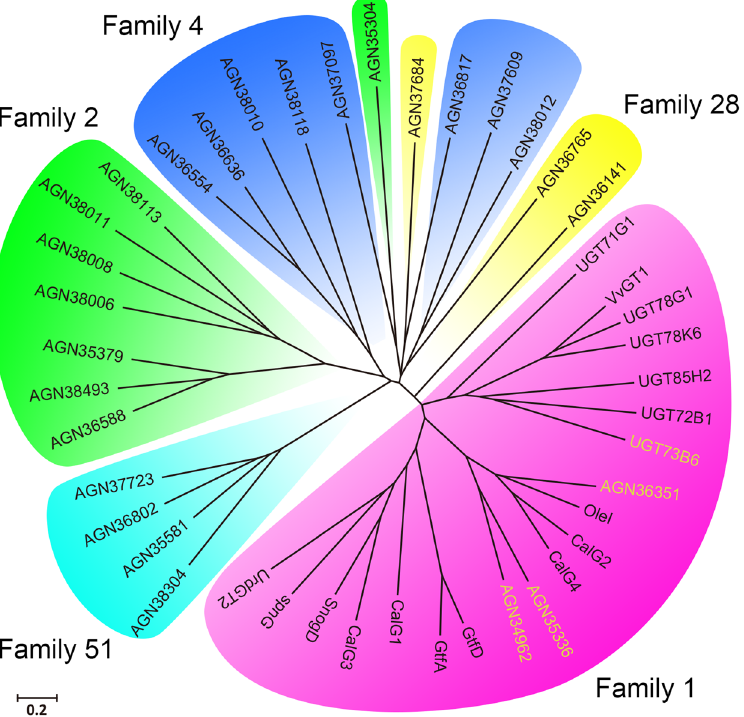
Figure 1. The phylogenetic tree of glycosyltransferases full sequences. The glycosyltransferases (GTs) sequence obtained from the NCBI database, including plant GTs(UGT73B6, UGT85H2, UGT72B1, UGT78K6, UGT78G1, VvGT1, UGT71G1), microorganism GTs(OleI, CalG4, CalG2, GtfA, GtfB, GtfD, spnG, UrdGT2, CalG1, CalG3, SnogD and GTs from Bacillus licheniformis